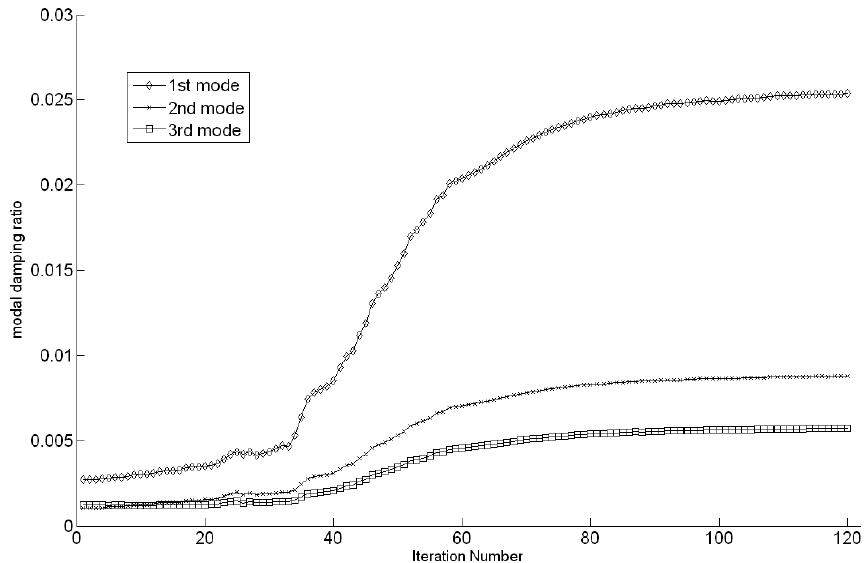
Fig. 20. Iteration histories for different modes vf = 0.2.